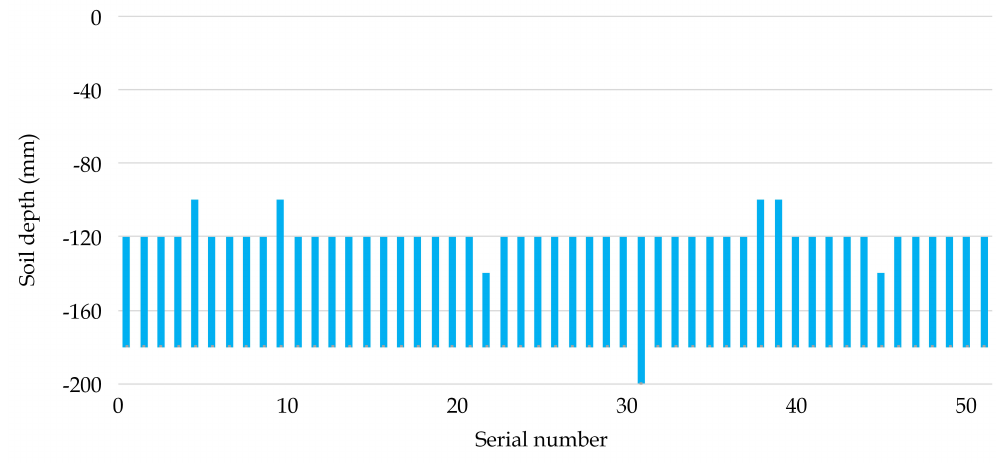
Figure 10. Fertilizer depth diagram of 50